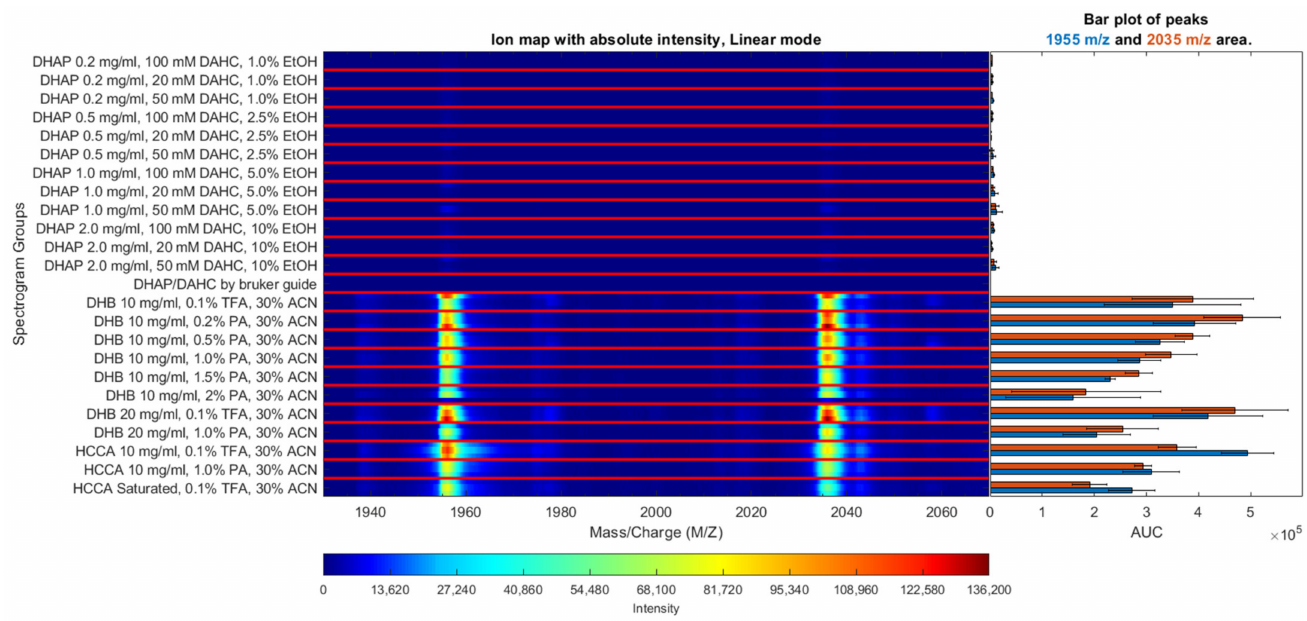
Figure 2. Ion map for pSer8-A β 16 mass spectra obtained using DHAP, HCCA, and DHB matrices with the addition of various concentrations of phosphoric and trifluoroacetic acid. A β 16 corresponds to m / z 1955; pSer8-A β 16 corresponds to m / z